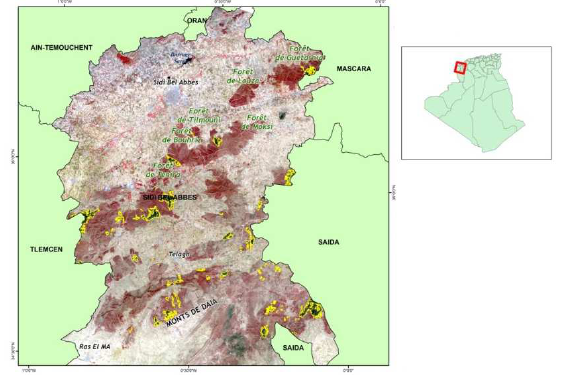
Figure 1. Areas affected by forest fires in the department of Sidi Bel Abbes summer 2015